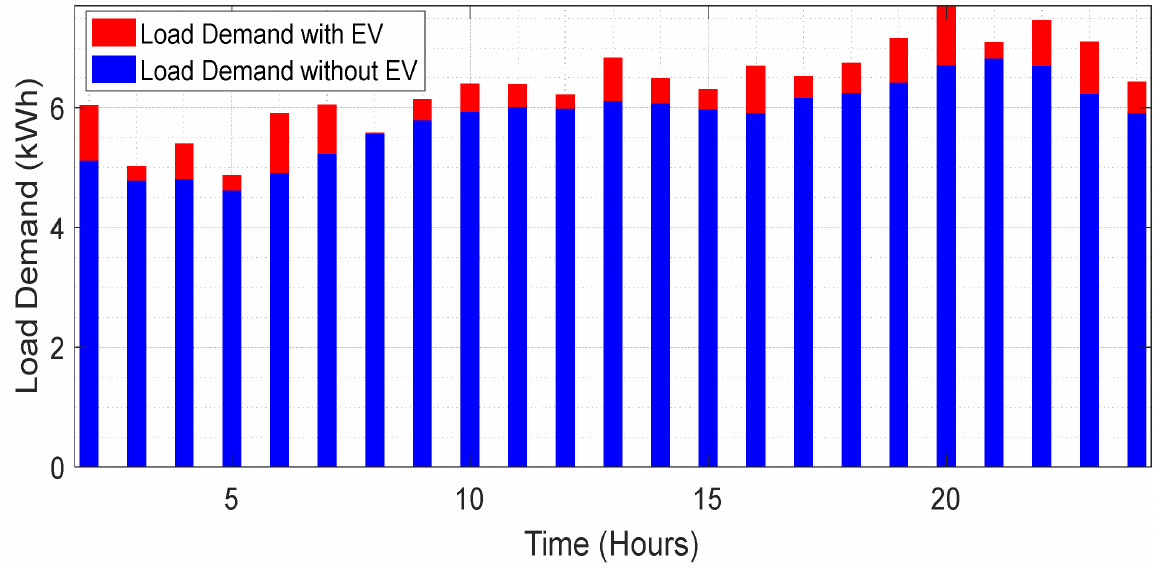
Figure 8. Load changes with EV and without EV